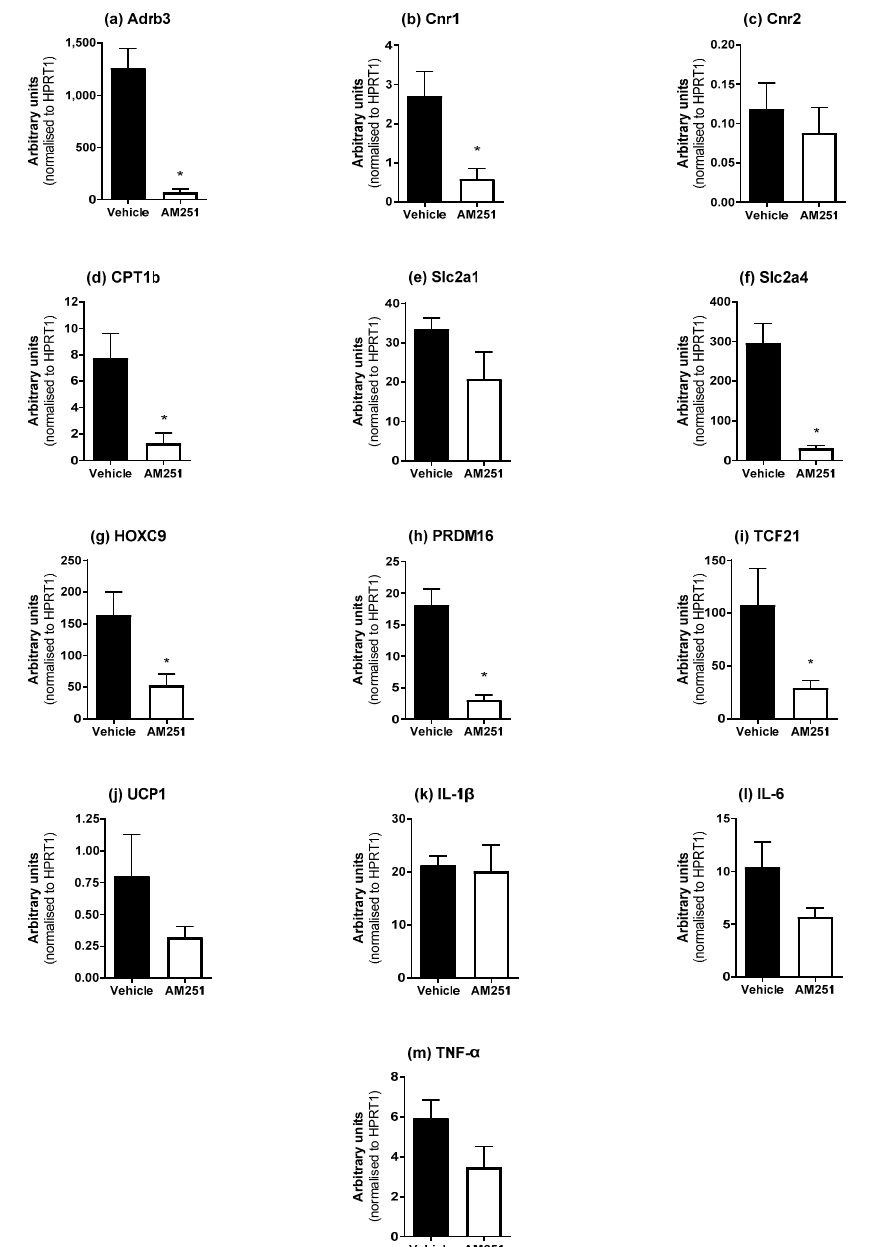
Figure 3. Effect of AM251 treatment in HFD rats on epididymal WAT mRNA expression. HFD rats were injected daily with either AM251 (3 mg/kg of body weight, ip) or vehicle for six weeks. All results are presented as a mean ± SEM in arbitrary units (normalized to housekeeping gene HPRT1) from n = 6–9 (AM251) and n = 7–9 (vehicle) treated rats on an HFD. Significance * p ≤ 0.05 compared to vehicle.